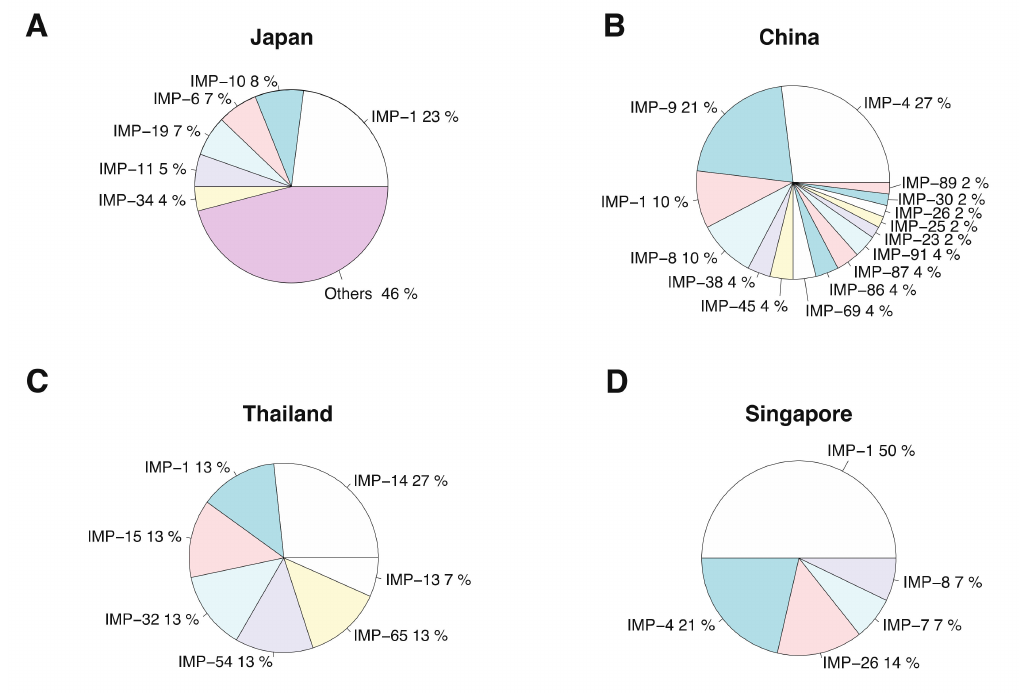
Figure 2. Distribution of bla IMP annotated genes in four countries in Asia: ( A ) Japan, ( B ) China, ( C ) Thailand and ( D ) Singapore. IMP-N is used to represent